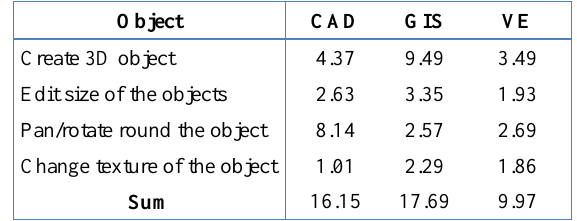
Table 1. Time taken for the tasks per environment (efficiency)